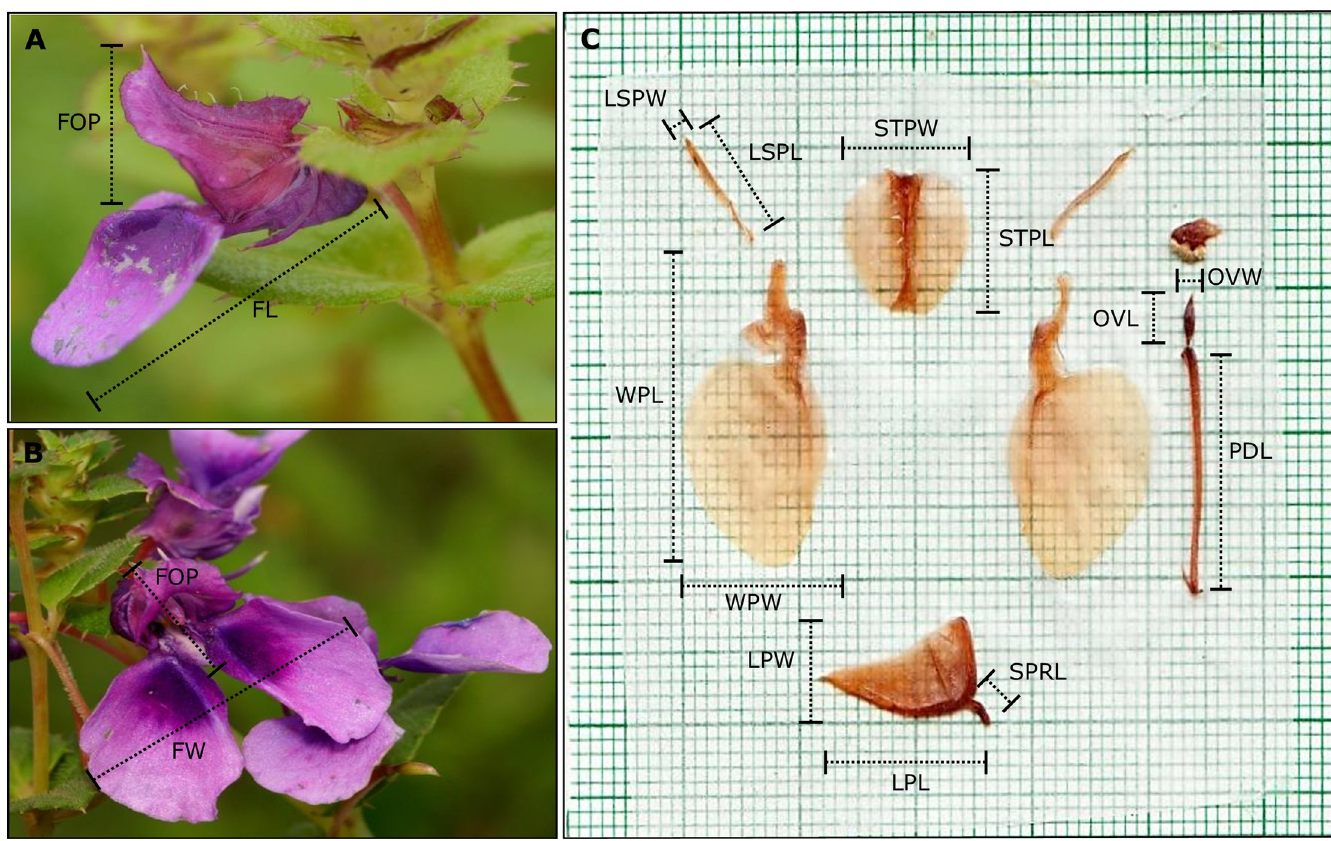
Fig 1. Morphological characters studied in Impatiens lawii flowers. (A) Side view of the whole flower and (B) Front view of the flower, depicting the three- dimensional characters measured. (C) Quantification of dissected floral parts. Refer to Table 1 for the details of character abbreviations.